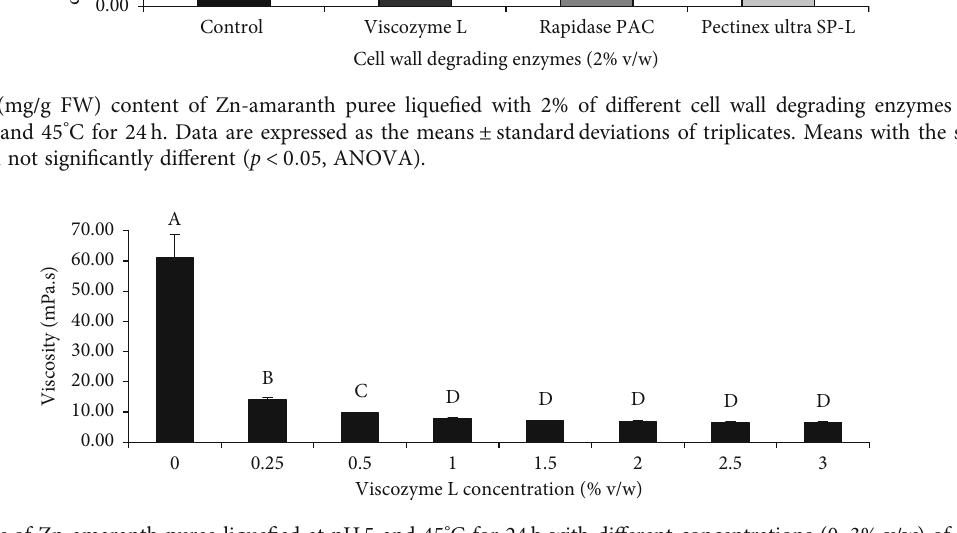
Figure 3: Viscosity of Zn-amaranth puree lique fi ed at pH 5 and 45 ° C for 24h with di ff erent concentrations (0 – 3% v/w) of Viscozyme L. Data are expressed as the means ± standard deviations of triplicates. Means with the same letter in each column mean not signi fi cantly di ff erent ( p < 0 : 05 ,